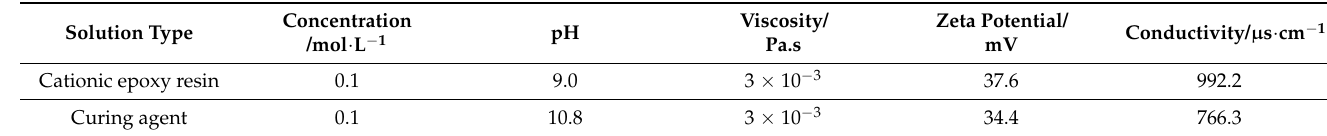
Table 1. Basic properties of